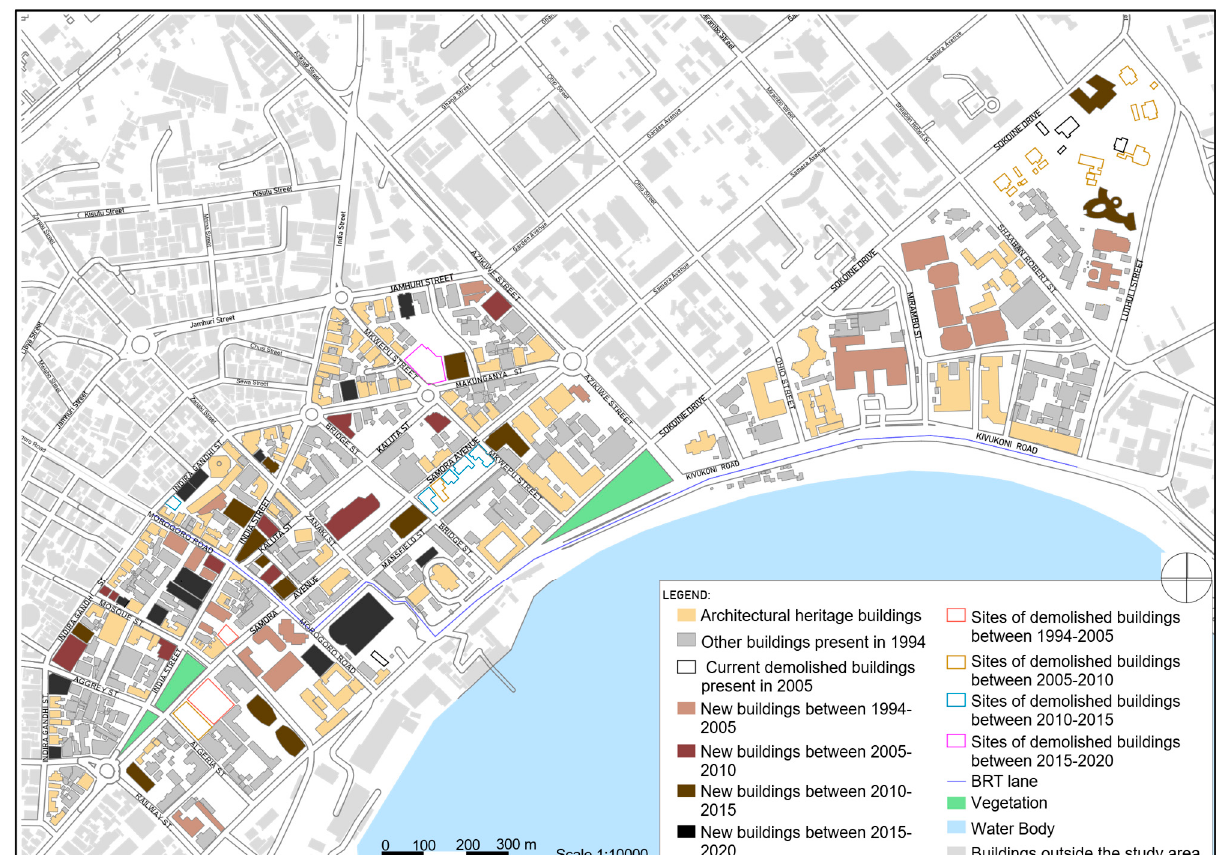
Figure 5. Demolitions and new buildings between 1994 and 2020. (Modified from satellite images 1967, 1994, 2005,